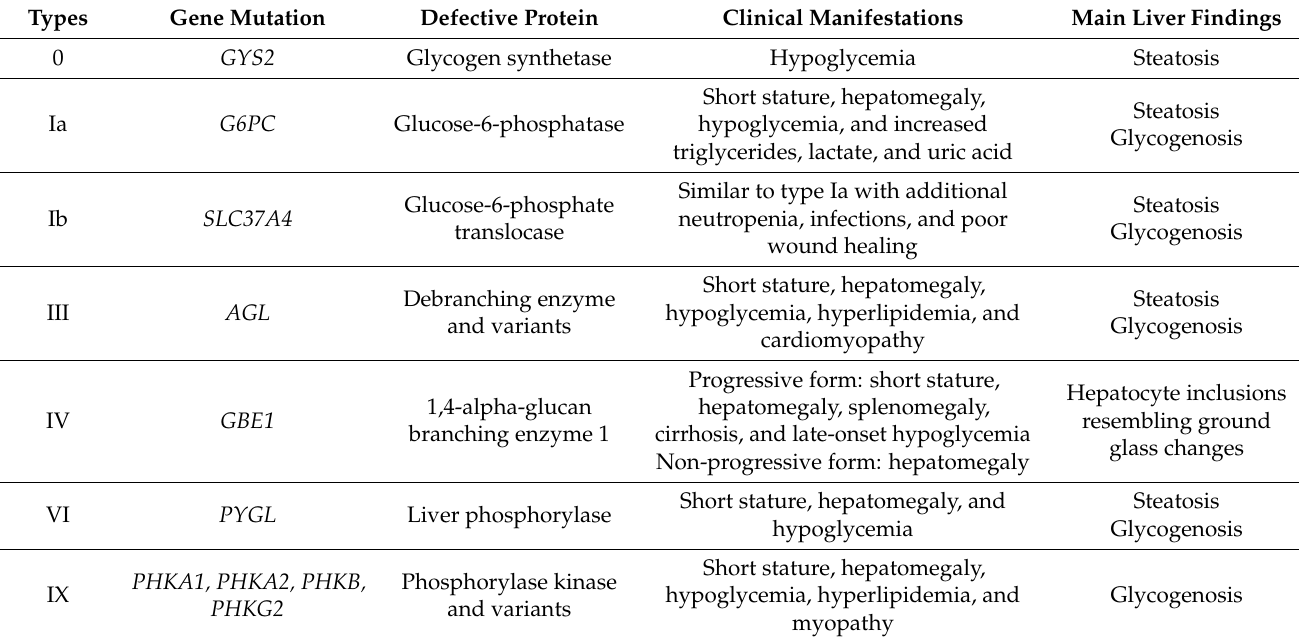
Table 1. Glycogen storage disorders that primarily affect the liver